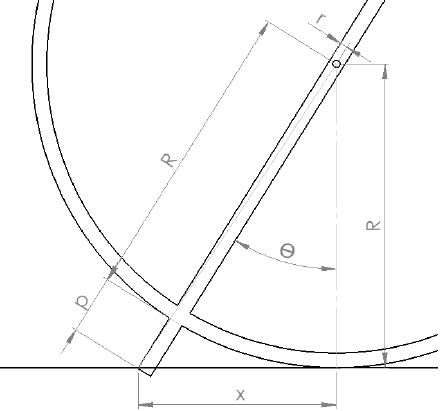
Figure 19. Geometry of spiked wheel at position 1.